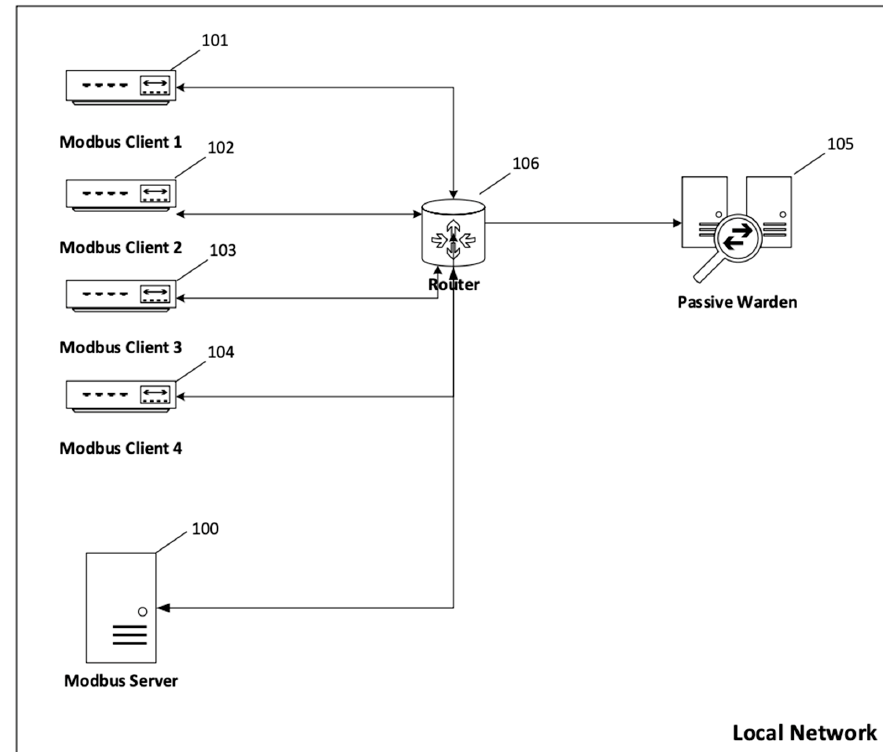
Figure 8. Multi-device architecture.